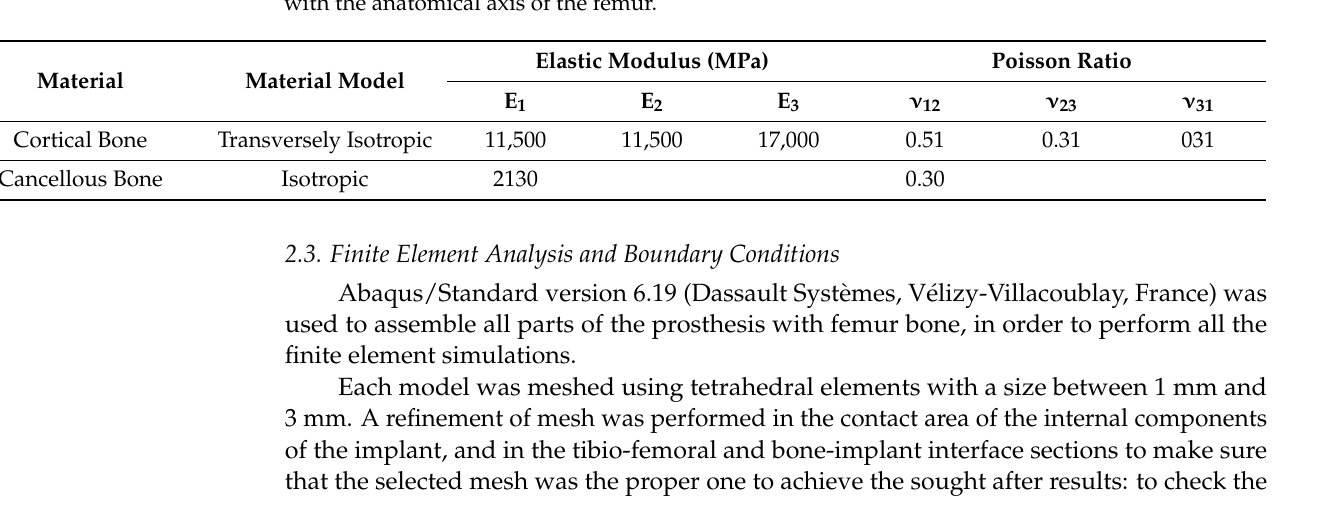
Table 2. Material properties of the femoral bone used for all models; the third axis was taken parallel with the anatomical axis of the